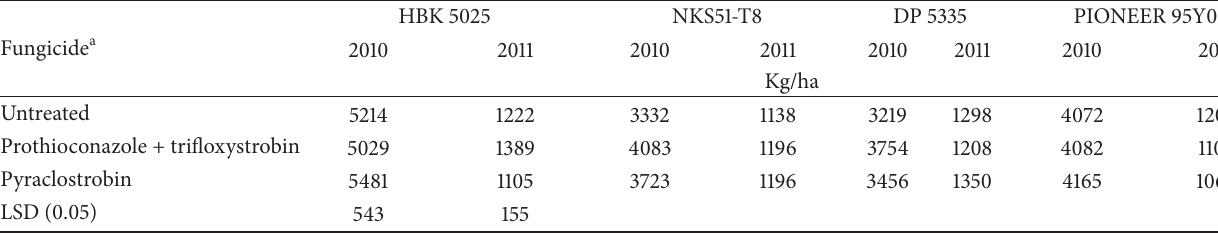
Table 2: Soybean cultivar yield response to fungicides under no disease pressure.